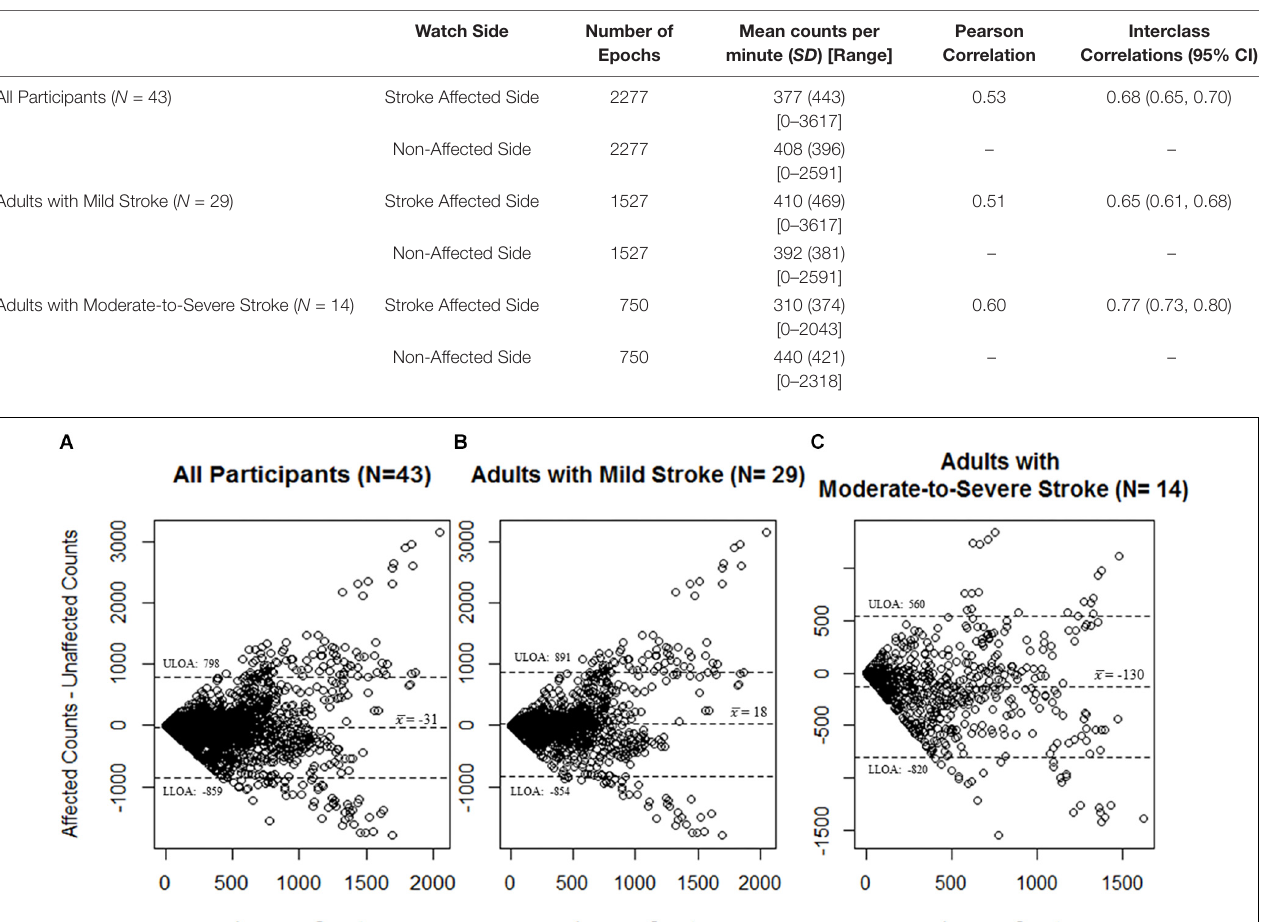
TABLE 2 | Agreement of the MotionWatch8 for adults with stroke.